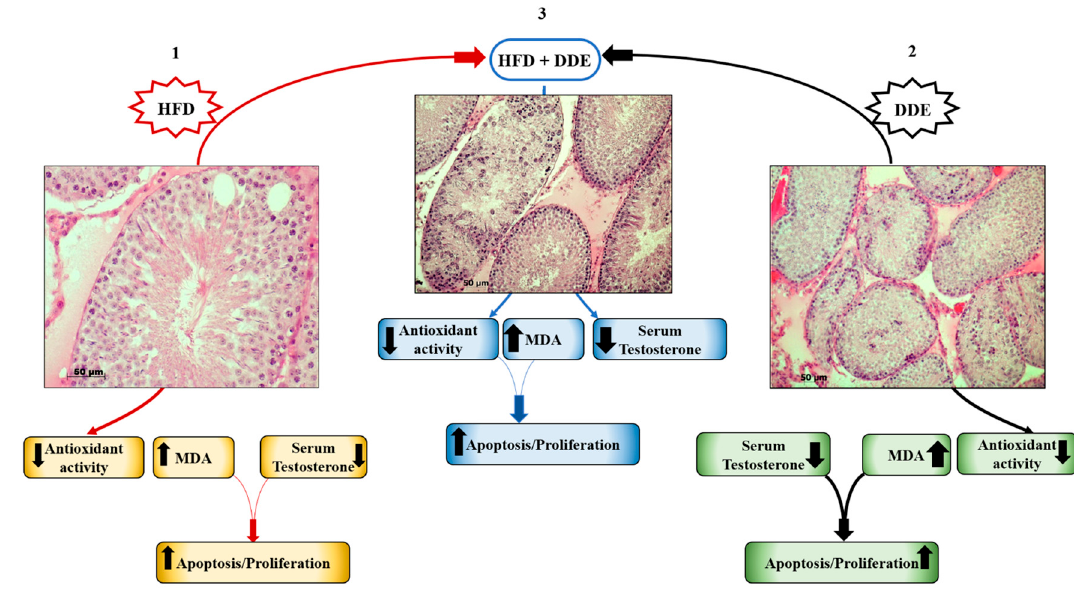
Figure 3. E ff ects of singular and simultaneous exposure to a high-fat diet (HFD) and / or dichlorodiphenyldichloroethylene (DDE) in testis. HFD (1) reduced antioxidant activity and generated oxidative stress. Increases in the apoptotic rate were found. In addition, dietary fats reduced serum testosterone levels, altering the hormonal balance. Both DDE exposure (2) and simultaneous HFD and DDE exposure (3) a ff ected antioxidant system activity, which was strongly reduced. Oxidative damage further increased, and to a much greater extent in DDE-treated animals (2). Moreover, a trigger of apoptosis, tubular damage, and a reduction of testosterone levels were detected. To counteract cellular death, proliferation was stimulated in a similar way in HFD (1) and HFD + DDE (3), and was further increased in DDE (2), suggesting the di ff erent e ff ects of pesticides at a cellular